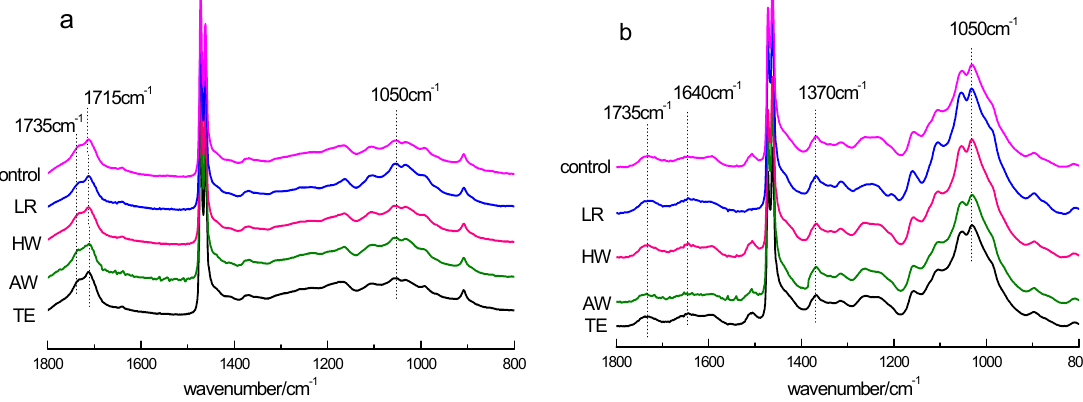
Figure 1. FTIR spectra of WPCs before and after weathering ( a ) after weathering; ( b ) before weathering.